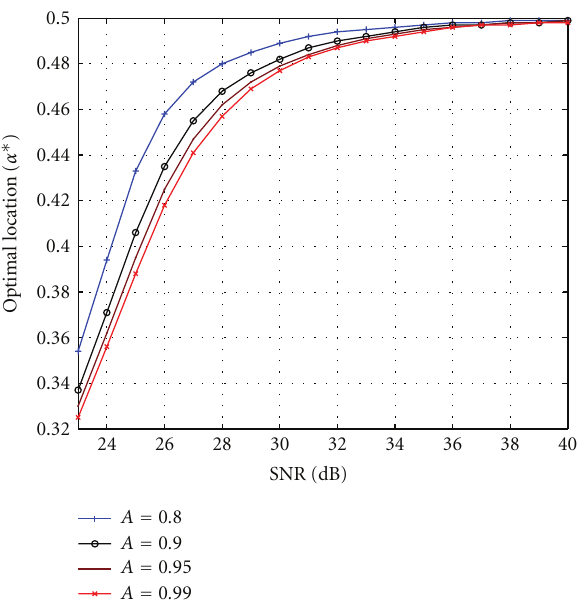
Figure 7: Analytical optimal location of the intermediate fusion helper under the AND combining rule in Gaussian channels ( β = 3 . 5, d = 10, π 0 = π 1 = 0 .